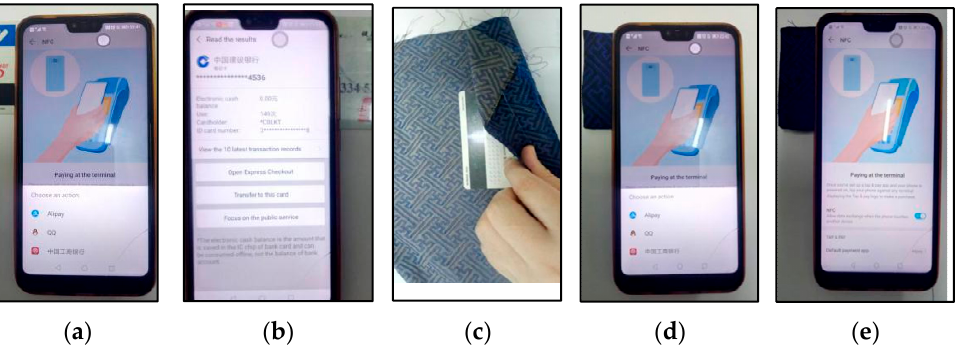
Figure 8. Practical measurement with NFC function in mobile phone (( a ): the mobile phone read unprotected IC cards, ( b ): the details of IC card, ( c ): wrapping IC cards with the sample S2, ( d ): the reading situation of the mobile phone from the wrapped IC card and ( e ): no signal response shown on the mobile phone).